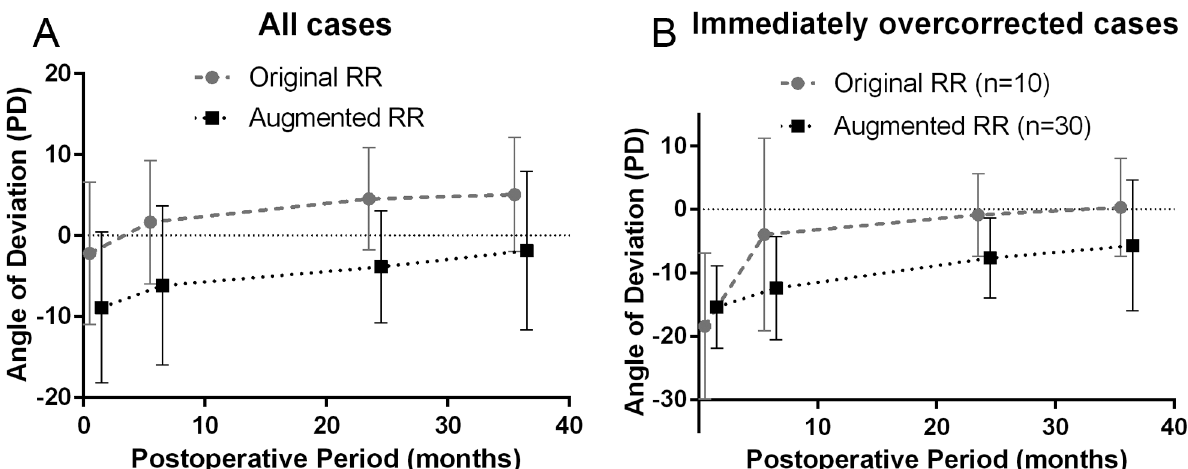
Fig 3. Exodrifts. The mean angle of deviations at each postoperative periodafter the originalunilaterallateral rectus recession-medial rectus resection(RR) and the augmented RR. In all enrolledcases ( A ), the exodrift rates of the two groups were almost parallelthroughout the observation period and showeda continuousdecrease after surgery. In overcorrected cases at 1 month after surgery ( B ), exodrift rates also showeda continuous decreaseafter surgery. PD = prism diopters.